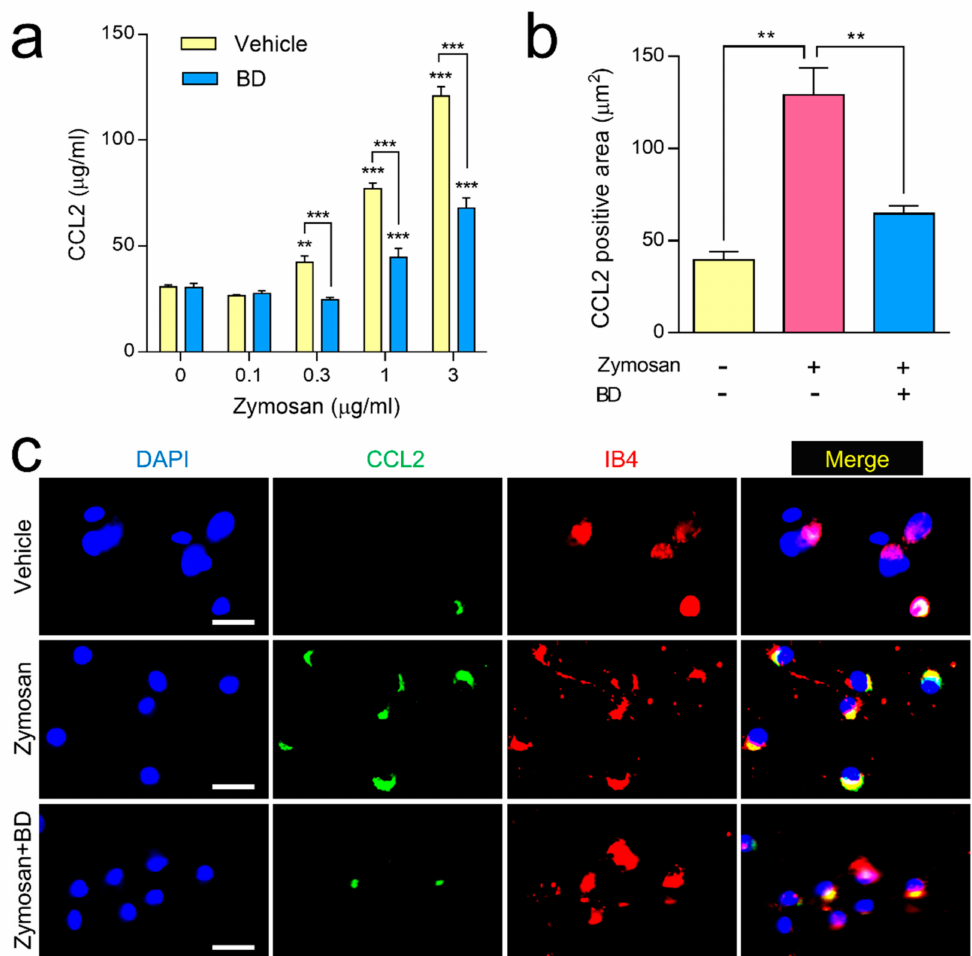
Figure 1. The effect of BD1047 (BD) on zymosan-induced CCL2 release in dorsal root ganglion (DRG) primary culture. ( a ) Zymosan incubation dose-dependently increased CCL2 release in the DRG primary culture cells as compared with vehicle control, which was reversed by BD (10 µ M). ** p < 0.01, *** p < 0.001 (compared with 0 µ g/mL of zymosan of each group; data represent the mean ± SEM of three independent experiments; Bonferroni’s multiple comparison test). ( b ) Increased CCL2 immunoreactivity in DRG neurons during zymosan incubation (3 µ g/mL) was reversed by BD (10 µ M). ** p < 0.01 ( n = 3; data represent the mean ± SEM; Tukey’s multiple comparison test) ( c ) In the triple-labeling study, the zymosan-induced CCL2 immunoreactivity predominantly overlapped with IB4. Scale bar = 50 µ